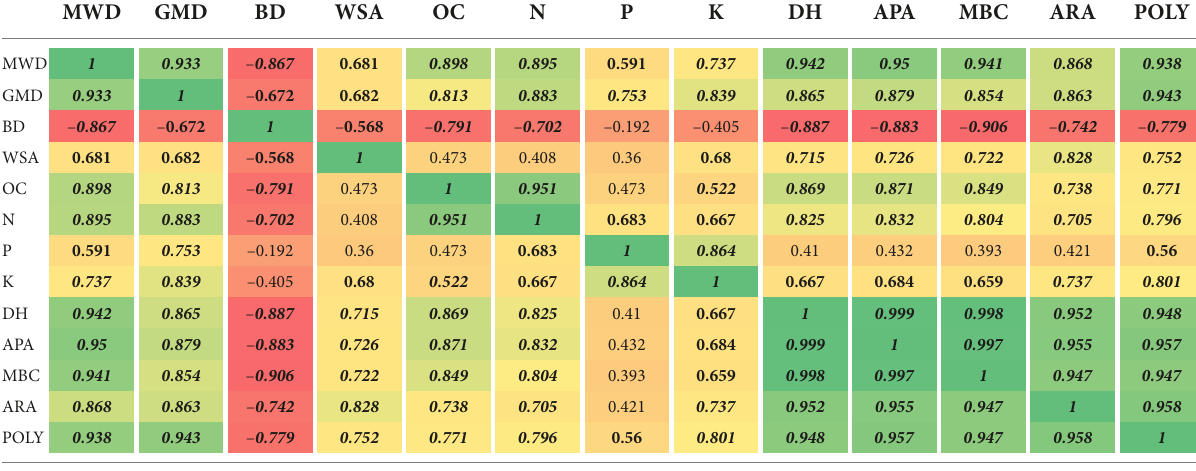
TABLE 7 Correlation coefficient (r)* matrix between soil physical, chemical, and biological